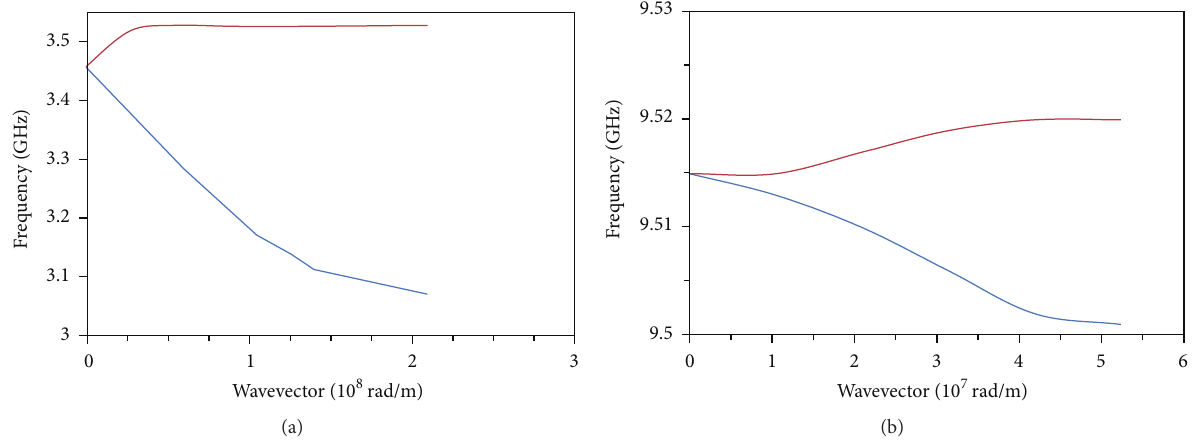
Figure 5: Dispersion relations of SW localized within the primary sublattice ((a), 𝑎 1 = 15 nm), and secondary sublattice ((b), 𝑎 2 = 60 nm); in (a) and (b), the red line corresponds to the DE-like mode ( 𝑘 ⊥ 𝐵 ) and blue one to the BA-like mode ( 𝑘 ‖ 𝐵 ). Zone boundary is at = 2.09 × 10 8 rad/m (a) and 𝑘 = 5.23 × 10 7 rad/m (b). Note that in (b) the wavevector 𝑘 𝑘 1 2 𝑘 1 was extrapolated by phase map